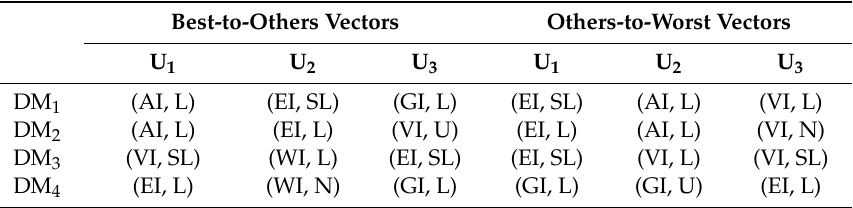
Table 8. The linguistic preference comparison vectors.